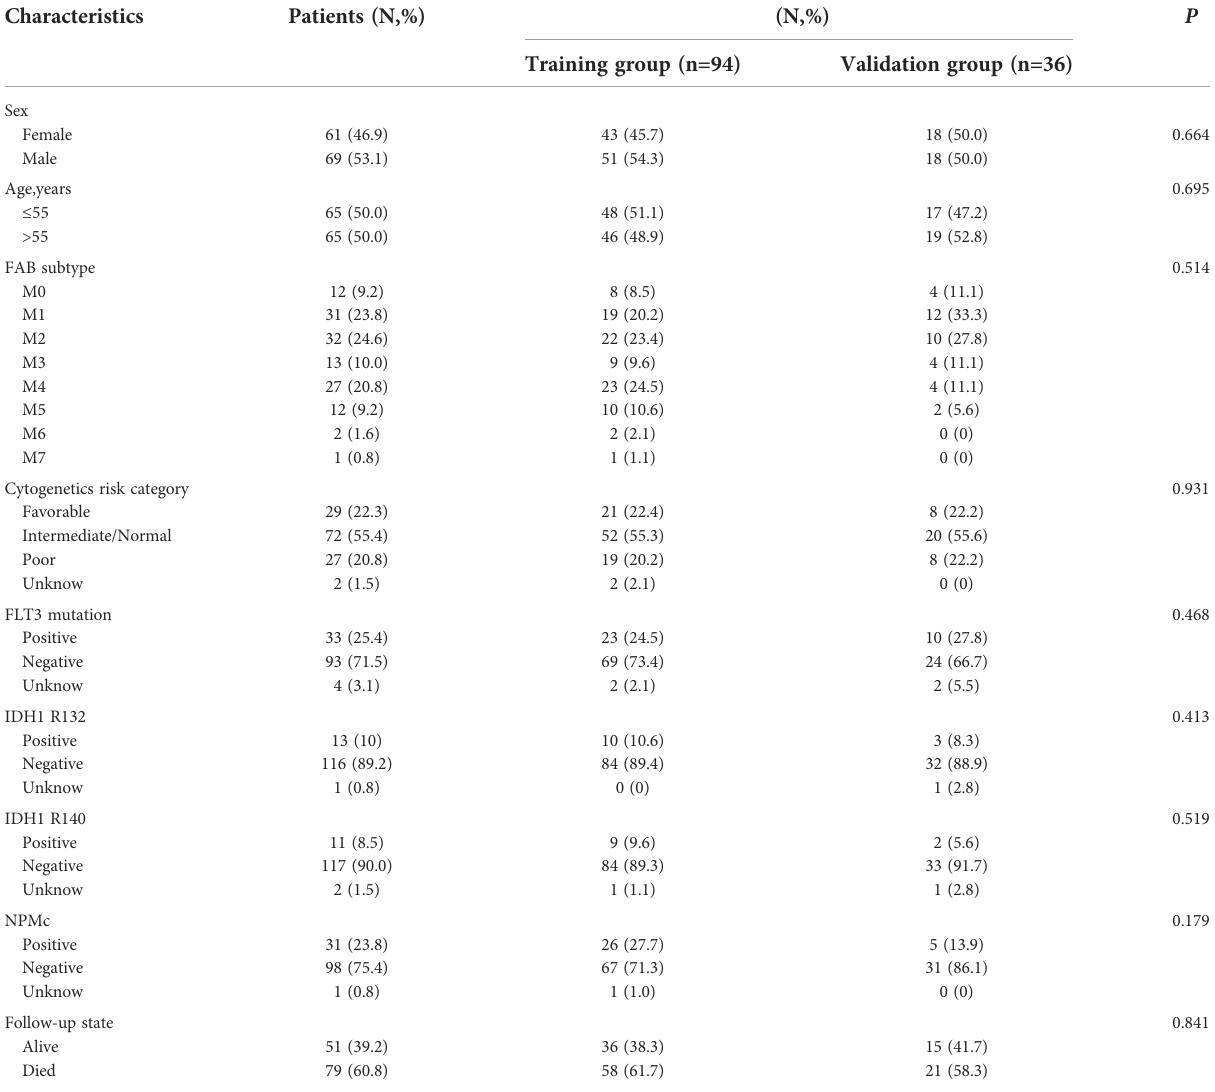
TABLE 1 Characteristics of patients with